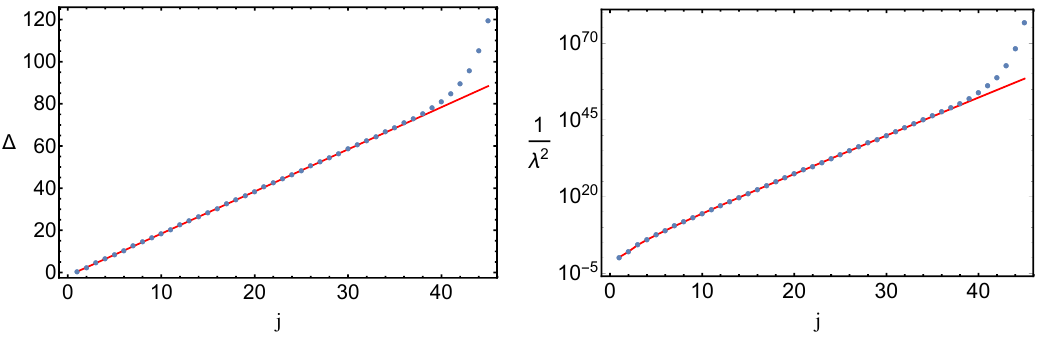
Figure 9 . Upgrading at a non-unitary point, with (cid:1) (cid:30) = (cid:0) 0 : 3. On the left, evolution of (cid:1) we increase the number of crosing constraints. The values seem to converge to the correct value 1 + 2(cid:1) (cid:30) = 0 : 4. Unlike the usual unitary bootstrap, the curve here does not have a meaning of a bound. Accordingly the value (cid:1) does not need to decrease as we add more constraints, and gap in fact here it does the opposite. On the right, the leading, negative, OPE coe(cid:14)cient squared, compared with the exact value (cid:21) 2 = 2(cid:1) (cid:30) = (cid:0) 0 : 6. j =0